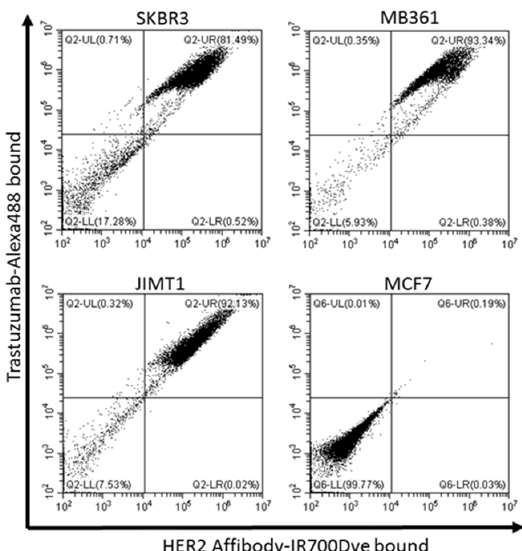
Figure 4. Flow cytometry after double labeling of HER2 Affibody-IR700Dye conjugate and trastuzumab-Alexa488 conjugate to HER2 receptors. Both IR700Dye and Alexa488 showed a strong fluorescence intensity and revealed specific binding of HER2 receptors on HER2-positive cells (SK- BR3, MDA-MB361, and JIMT1) without labeling to HER2-negative cells (MCF7). Representatives of each experiment are shown by dot plots.